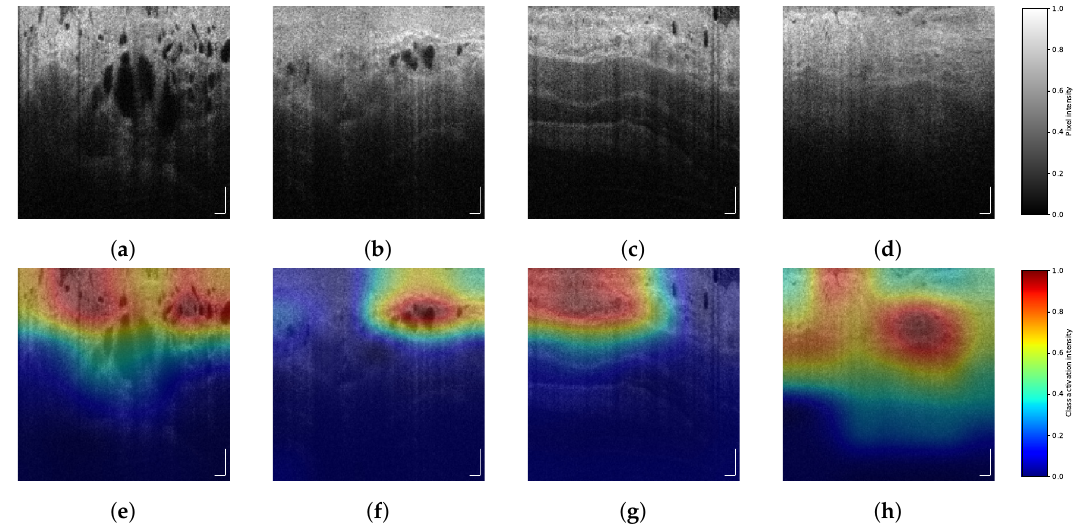
Figure 5. (Best viewed in color) Several VLE frames and its corresponding class activation maps (CAM). Images ( a , b ) belong to regions of interest (ROIs) with high-grade dysplasia (HGD), represented as class activation map (CAM) in images ( e , f ). Images ( c , d ) correspond to ROIs with non-dysplastic Barrett’s esopaghagus (NDBE), with its CAM in images ( g , h ). Scale bars: 0.5 mm. Color bar ( a – d ): pixel intensity. Color bar ( e – h ): class activation